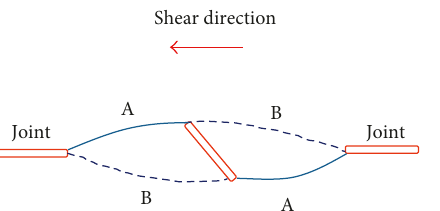
Figure 5: Schematic diagram of the main cracking trajectory in Series A.